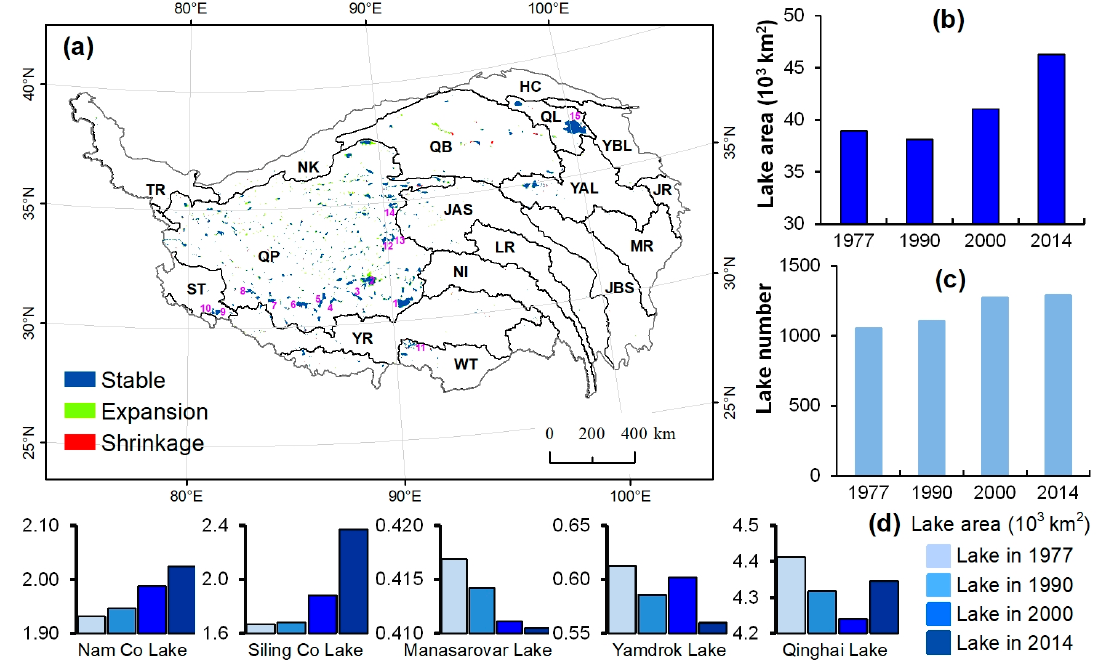
Figure 3. Spatial distribution and temporal changes of lakes. ( a ) Spatial pattern of Tibetan lake changes from 1977 to 2014; the numbers 1–15 denote specific lakes: 1, Nam Co; 2, Siling Co; 3, Gyaing Co; 4, Ngangze Co; 5, Tangra Yumco; 6, Zhari Namco; 7, Taro Co; 8, Ngangla Ringco; 9, Mapam Yumco; 10, La’nga Co; 11, Yamdrok Lake; 12, Dorsoidong Co; 13, Chibzhang Co; 14, Ulan UI Lake; 15, Qinghai Lake; ( b ) changes in total area of lakes (>1 km 2 ); ( c ) changes in total number of lakes (>1 km 2 ); and ( d ) changes in area of selected lakes (km 2 ).